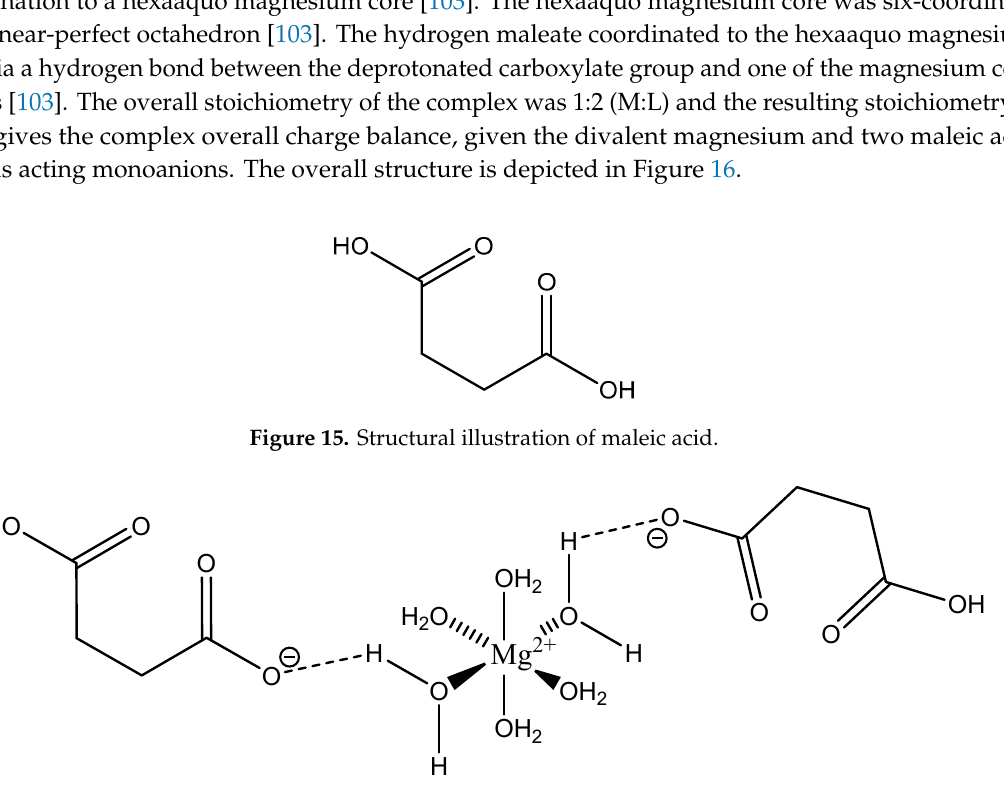
Figure 17. Structure of L -aspartic acid.